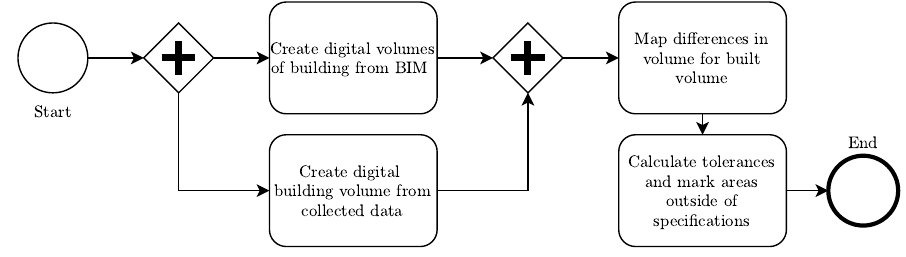
Figure 7. Progress monitoring workflow.